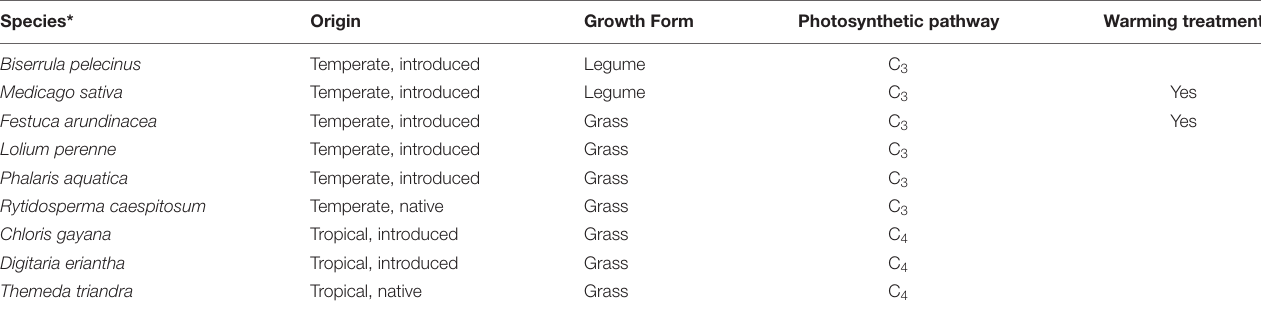
TABLE 1 | The origin, growth form and photosynthetic pathway of pasture and rangeland species selected for study in a drought and warming field experiment in the PACE facility.